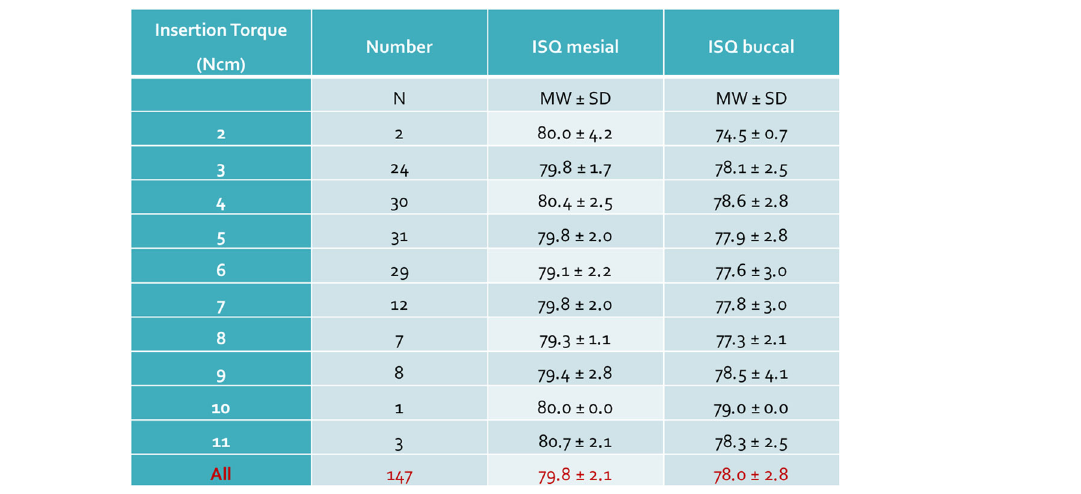
Table 2 Insertion torque relative to ISQ value for all